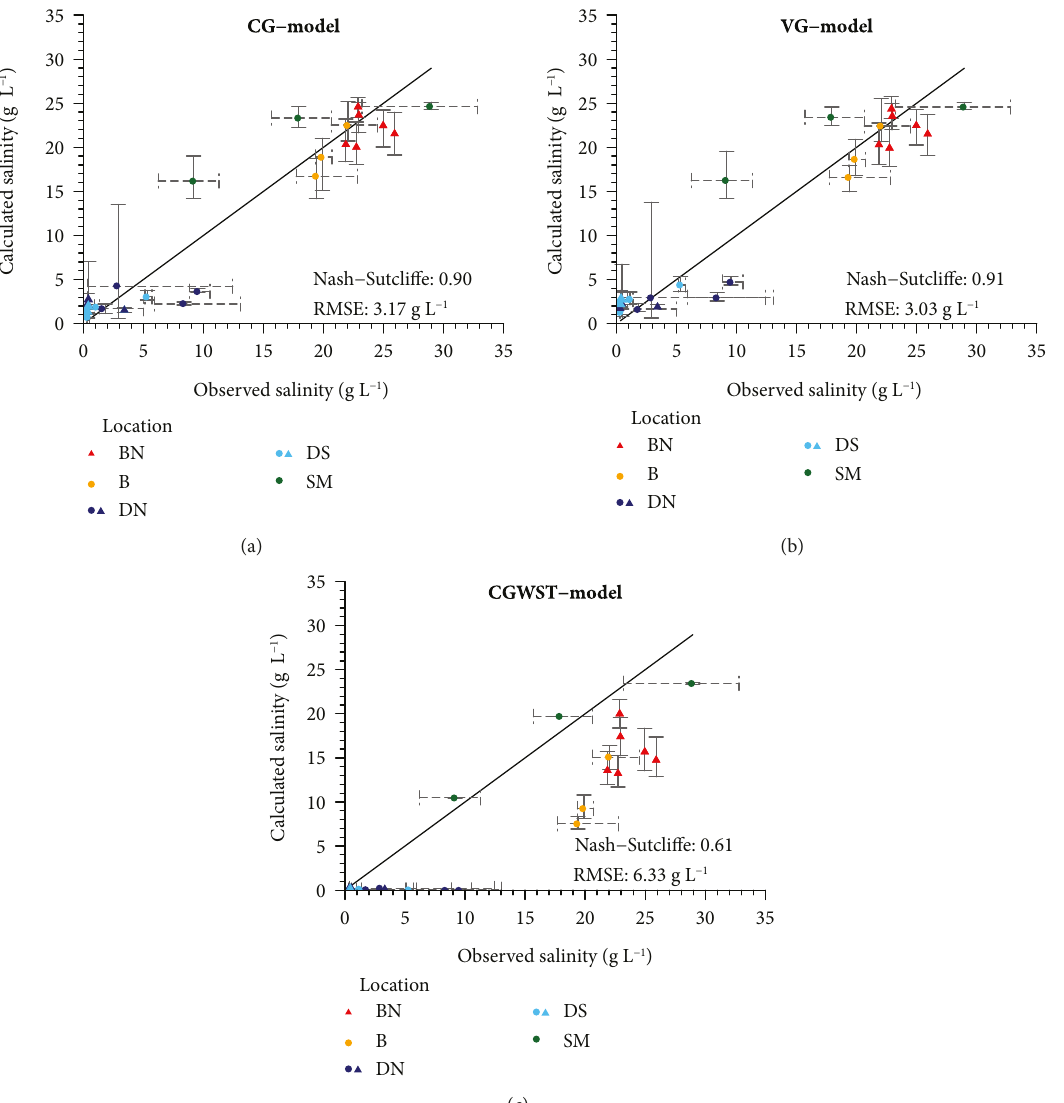
Figure 5: Scatter plots of observed versus calculated groundwater salinities after 42 years of simulation for the CG- (a), VG- (b), and CGWST-model (c). Vertical error bars represent the range of simulated salinities; horizontal error bars correspond to the range of observed salinities. In addition, one-o ff Direct-Push measurements of September 2016 are displayed (marked with